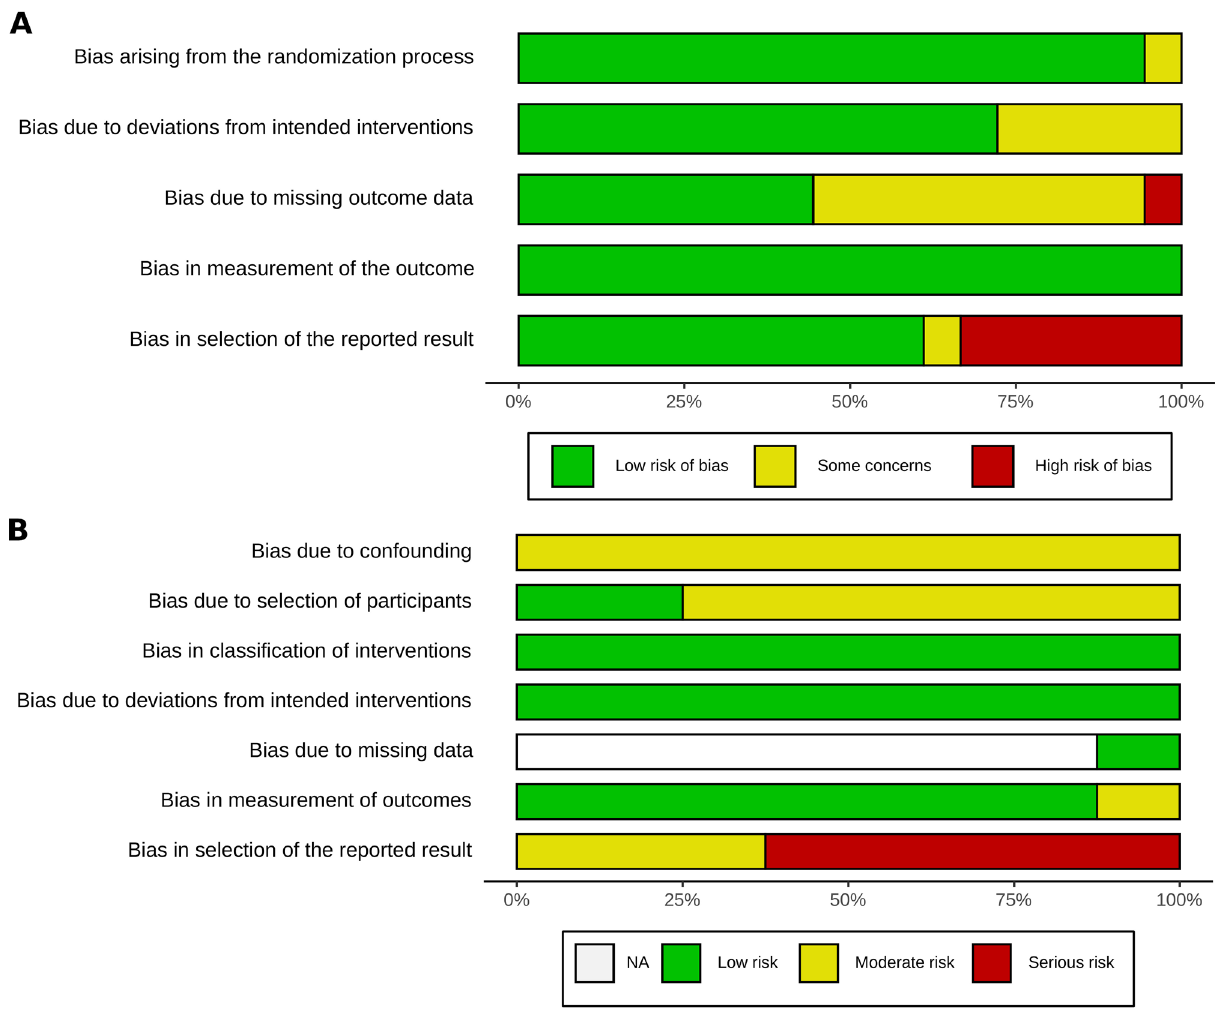
Figure 2. ( A ) Bias assessement bias assesment tool for RCT’s (ROB-2) and ( B ) bias assesment tool for non randomized studies